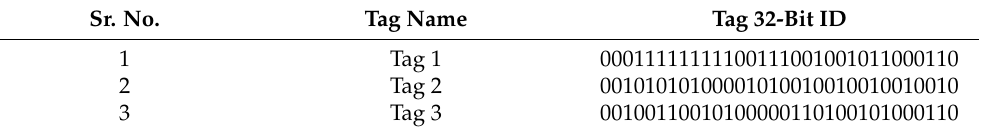
Table 2. List of tags and their IDs.